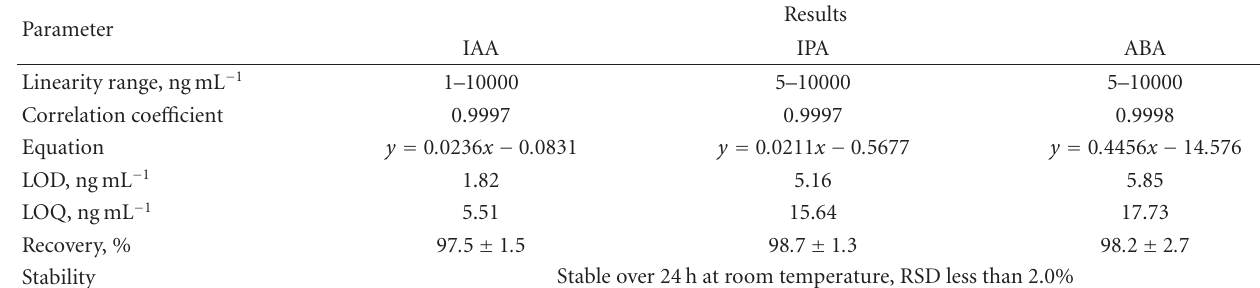
Table 2: Validation